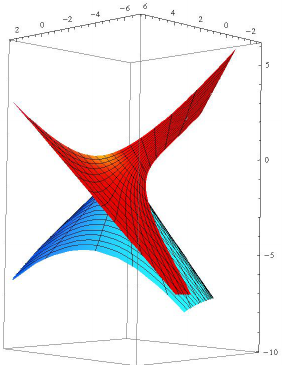
Figure 2. The red (blue) surface is the null scroll with generalized T ( B ) -lightlike ruling X 1 ( X 2 ) .